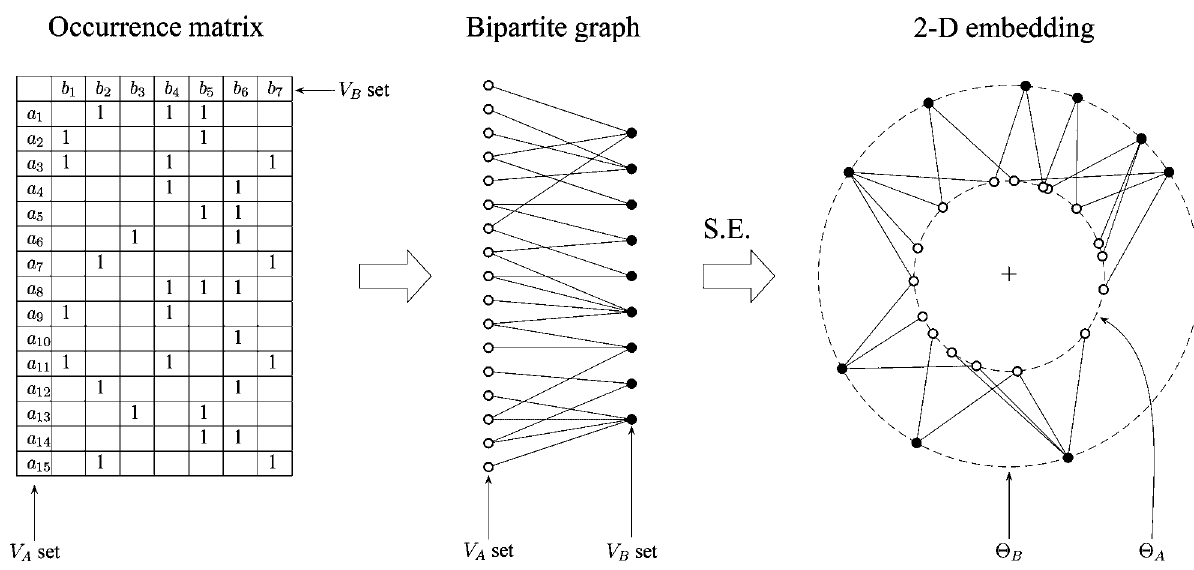
Figure 1. Visualization process: from the binary occurrence matrix O to the bipartite graph and its visualization using the SE algorithm. In each of the applications presented in section Applications, the most important information is the configuration of the graph’s vertices. The edges of the graph are not of primary interest here, they are not visualized by default, although the 3D-SE viewer allows displaying